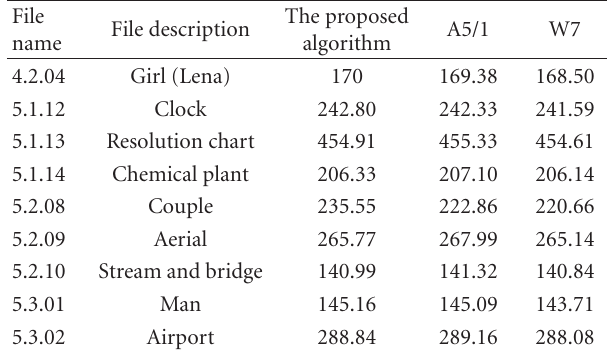
Table 2: Quality results of encrypted images. Grayscale type with 256 × 256